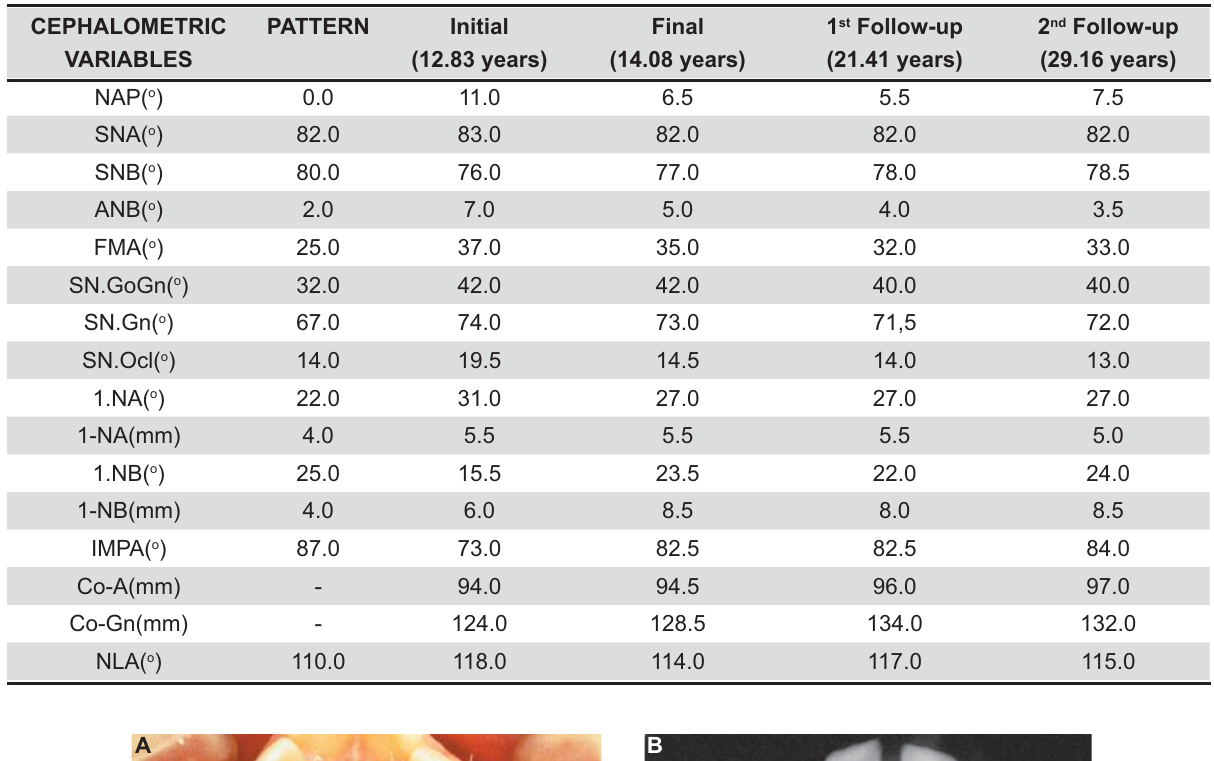
Table 1- (cid:2)(cid:3)(cid:4)(cid:5)(cid:6)(cid:5)(cid:7)(cid:8)(cid:9)(cid:2)(cid:10)(cid:4)(cid:7)(cid:8)(cid:9)(cid:2)(cid:11) st , and 2 nd follow-up cephalometric